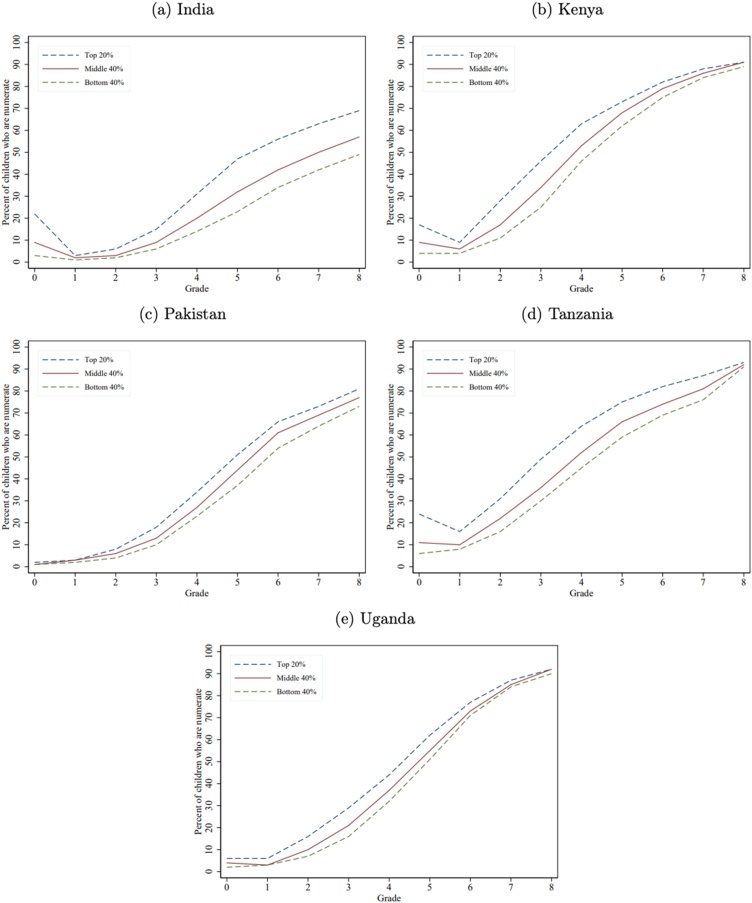
Learning Profiles by Wealth: Math (All Ages).